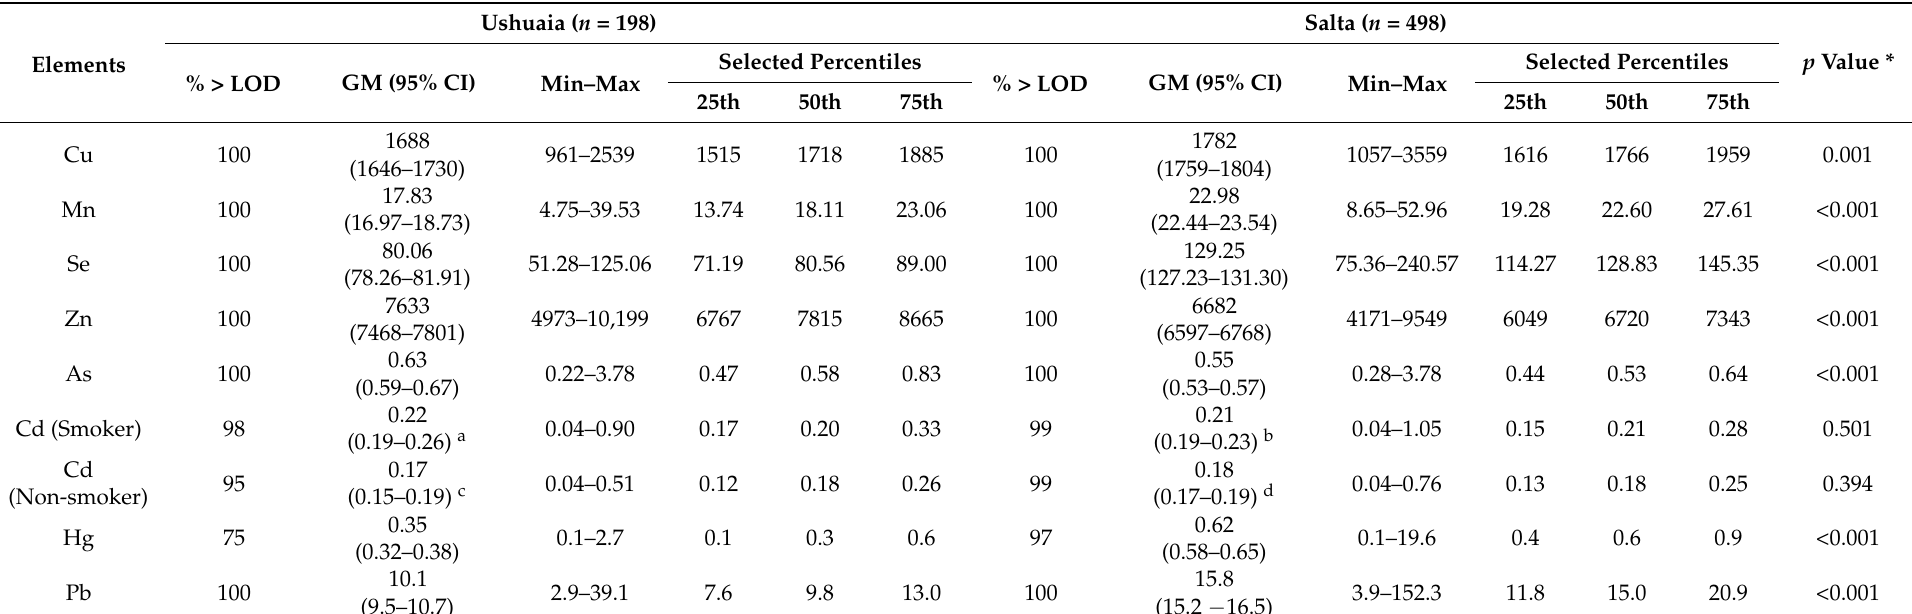
Table 2. Limits of detection and whole blood concentration ( µ g/L) of essential and toxic elements in Argentinian postpartum women living in Ushuaia and Salta ( n =